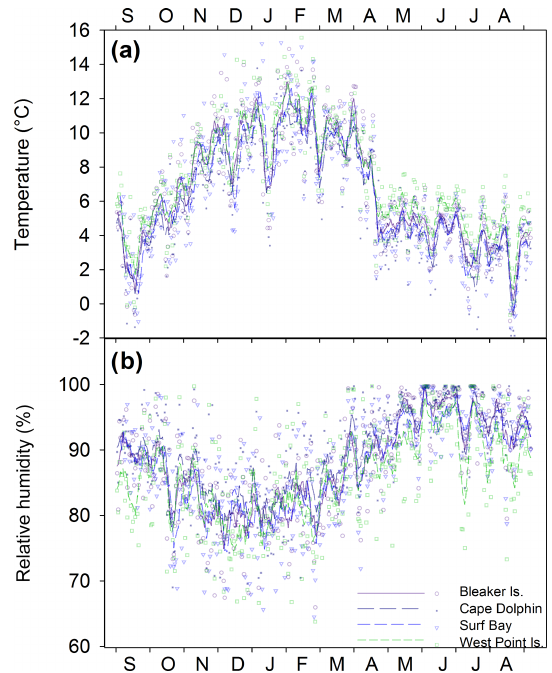
Figure 2. (a) Daily average temperature ( ◦ C) and (b) relative hu- midity (%) from September 2015–August 2016 at the four study lo- cations calculated from 2h measurements. The 7d running averages of daily average temperature and relative humidity are indicated by the lines for each study